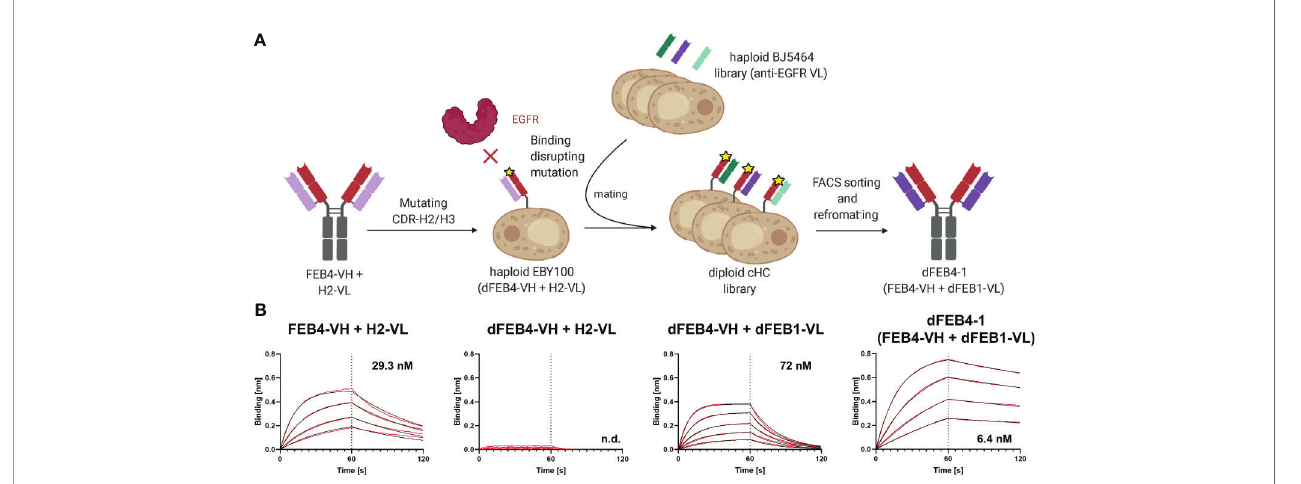
FIGURE 2 | Af fi nity maturation of EGFR-binding FEB4 (A) Schematic representation of light chain shuf fl ing approach. The mutations in the CDR-H2 and CDR-H3 disrupt the binding to EGFR. By shuf fl ing with a light chain immune repertoire derived from EGFR-immunized chicken by yeast mating and FACS sorting, an af fi nity maturated variant was isolated. (B) BLI af fi nity measurements of FEB4-derived antibodies at different maturation